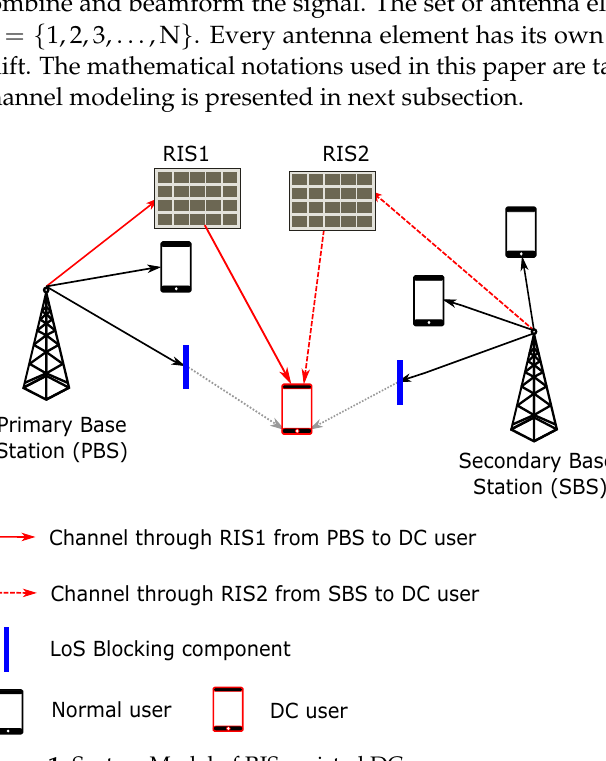
Figure 1. System Model of RIS-assisted